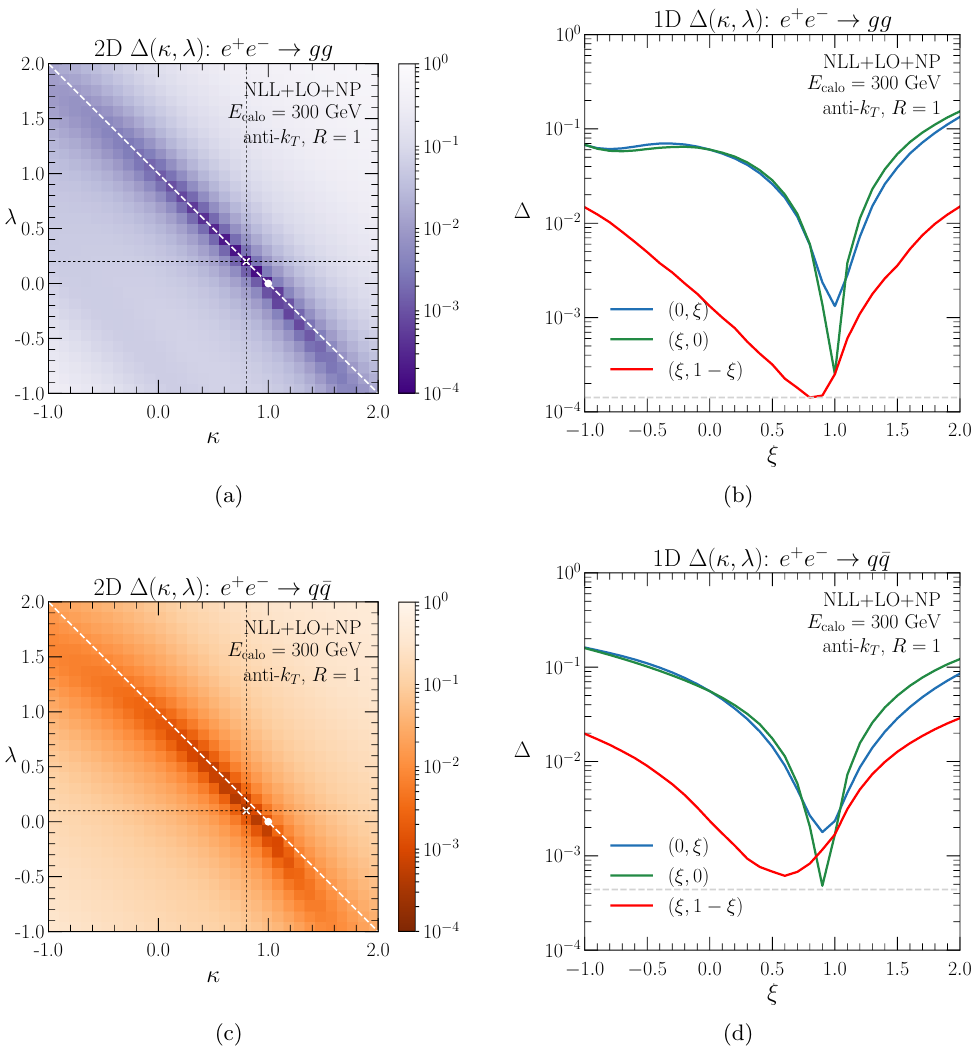
Figure 14 . Left column: distribution of (cid:1)( (cid:20); (cid:21) ) computed using the analytic NLL+LO distri- butions convolved with the shape function F NP for gluons (top) and down quarks (bottom). The white cross marks the best-(cid:12)t value, which is ( (cid:20); (cid:21) ) = (0 : 8 ; 0 : 2) for gluons and (0 : 8 ; 0 : 1) for down quarks. The white dot marks track-assisted mass, (cid:26) slices of the distributions on the left. The slight o(cid:11)set of the minimum values in (c) from the line (cid:21) = 1 (cid:20) manifests in the green ( (cid:24); 0) curve dipping below the red ( (cid:24); 1 (cid:0) intersecting again at (cid:24) =